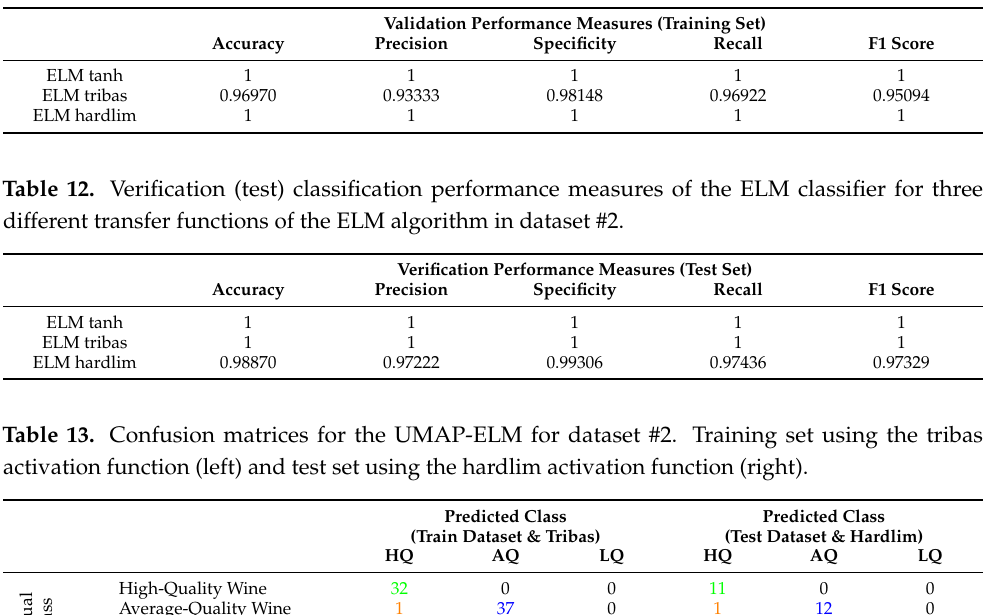
Table 11. Validation (train) classification performance measures of the ELM classifier for three different transfer functions of the ELM algorithm in dataset #2.